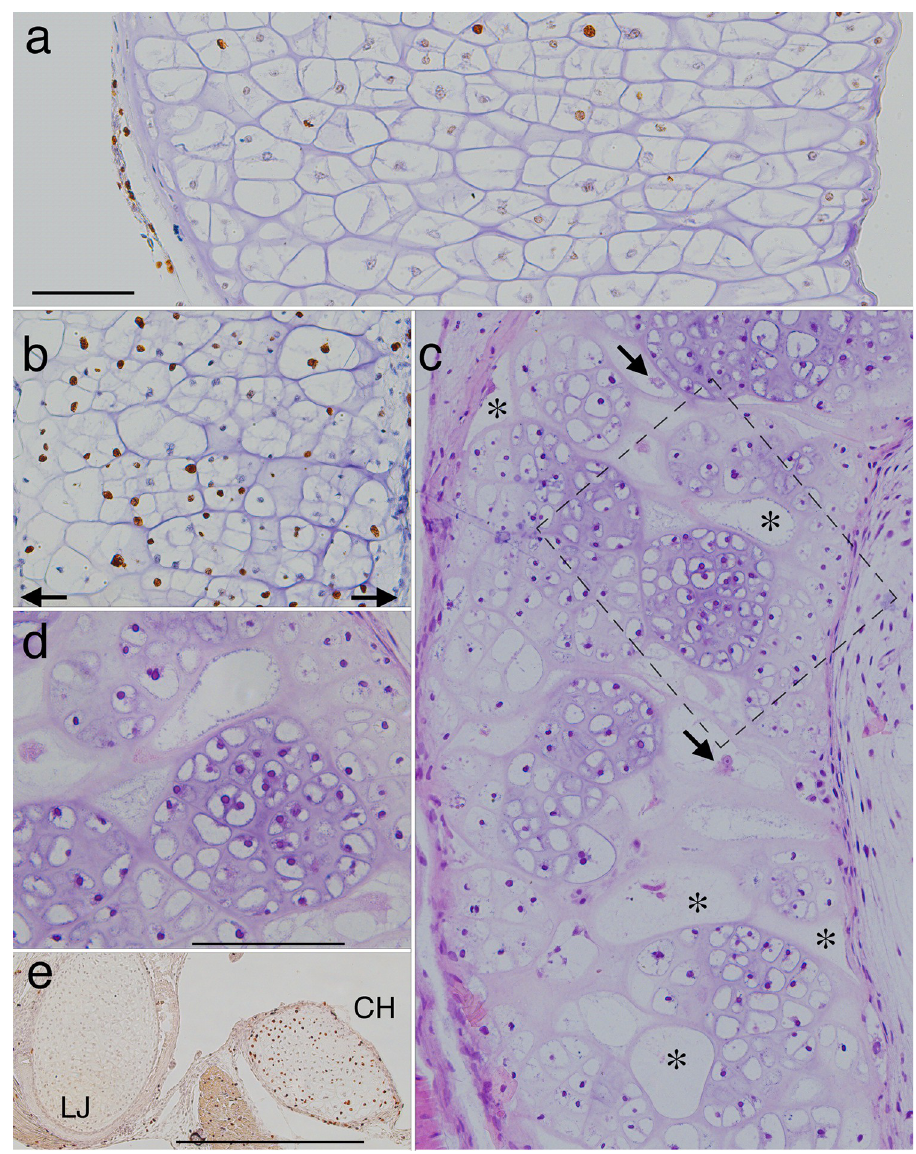
Fig 11. Sections through the proximal half of left ceratohyals showing metamorphic changes in cartilage histology, shape and cell features. Left is to the outside of the head and up is anterior in a-c and dorsal in e. (a and b) frontal, BrdU-labeled, hematoxylin-counterstained sections at late larval (NF 58) and late metamorphic (NF 64) stages respectively (arrows in b indicate the edges of the cartilage). (c) a frontal, resin-embedded, H&E stained section through the same region as a and b soon after metamorphosis (NF 66+). (d) a close up of the rectangular region outlined in c. (e) a transverse, BrdU-labeled, hematoxylin-counterstained section through the left lower jaw (LJ) and ceratohyal (CH) at NF 66. The transition from NF 58 to 64 (a to b) is marked by narrowing of the cartilage and most large chondrocytes acquiring more daughter nuclei and cells within their original perimeters. The transition from NF 64 to 66+ (b to c) is marked by the emergence of large, largely empty cell lacunae ( � ) that are interspersed across the width of the cartilage with discrete, equantly shaped cell clusters, and smaller lacunae that appear to contain cellular debris (arrows). While some lacunae resemble cluster outlines in b, others are transversely elongated with oval or more irregular shapes that generally conform to the curvature of adjacent cell clusters. The cell clusters contain many, small chondrocytes that have spherical nuclei and are separated by more matrix than the chondrocytes at NF 58. E shows high BrdU labeling in the ceratohyal, but not the lower jaw, at NF 66. Scale bars for a-d and e are 0.1 and 0.5 mm